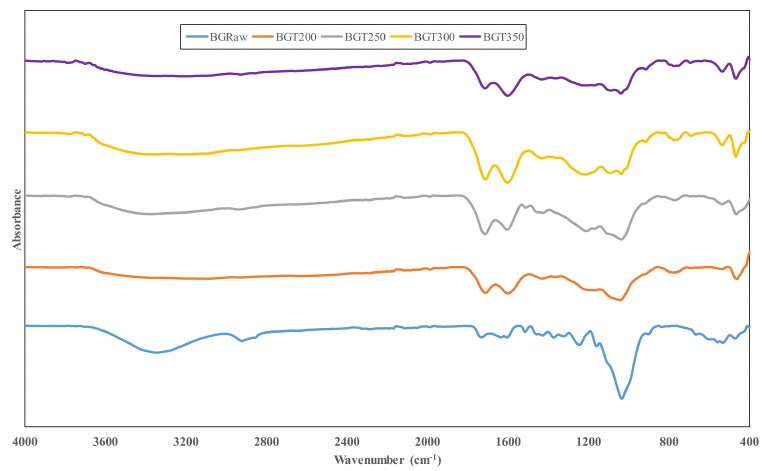
Figure 4. FTIR spectra of raw and torrefied sugarcane bagasse at varying